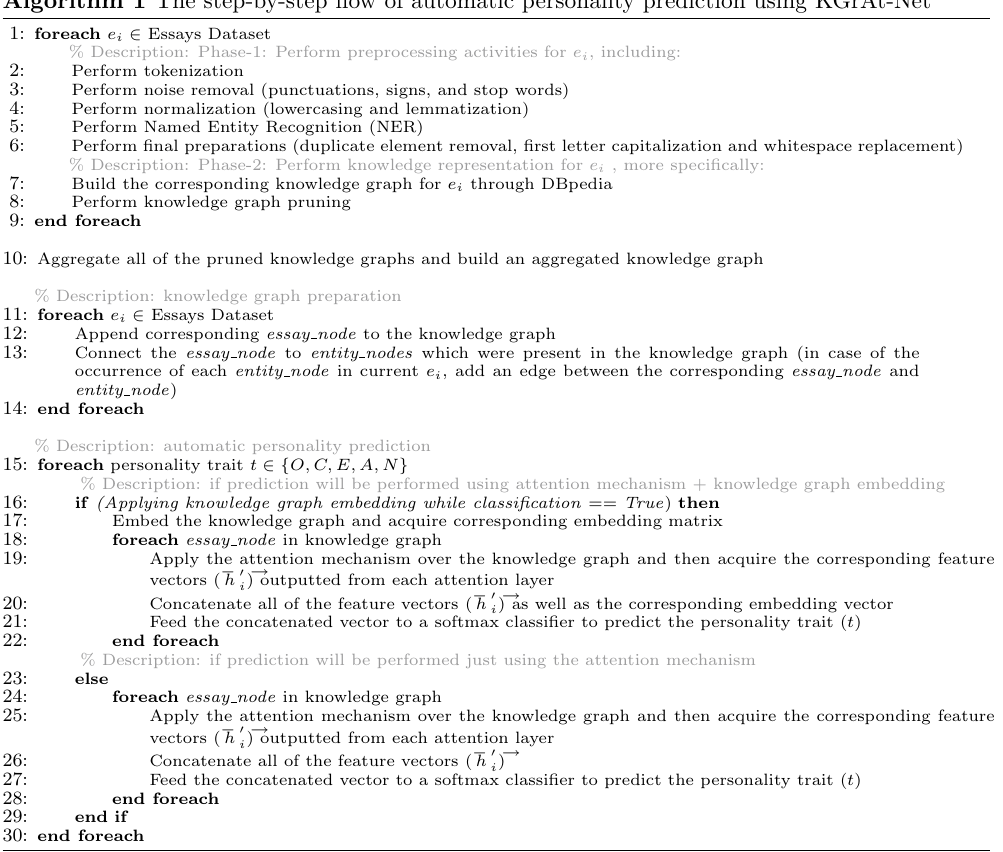
Algorithm 1 The step-by-step flow of automatic personality prediction using KGrAt-Net